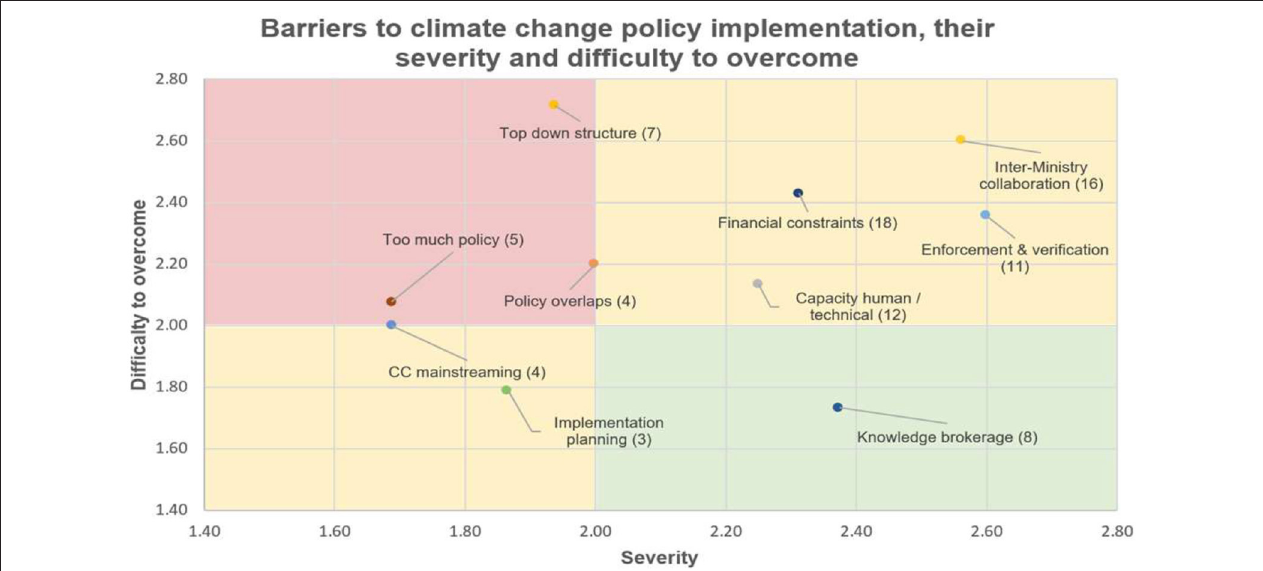
FIGURE 3 | Stakeholders’ perceived severity and difficulty to overcome of the barriers identified in the interviews, using the rankings from the survey results. The number following the barrier name is the frequency the barrier was identified in the interviews ( N = 25). The ranking for severity and difficulty to overcome is from the follow-up surveys ( N = 16). A table showing a breakdown of the different stakeholder groups that make up each category can be found in Appendix 2 in Supplementary Material